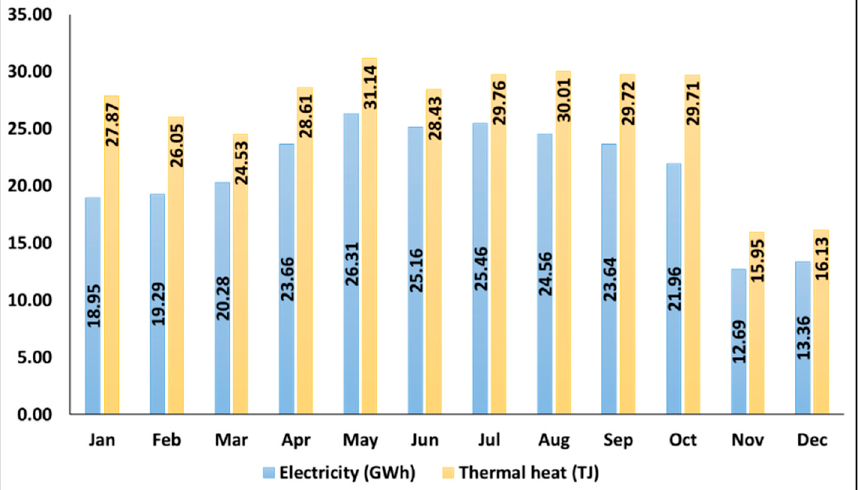
Figure 8. Monthly average electricity and thermal heat generation from the inversion scenarios in UB (Estimated by the authors). Table 6. Power/heat and expected reductions in GHG emissions and AP in each scenario (Estimated by the authors).